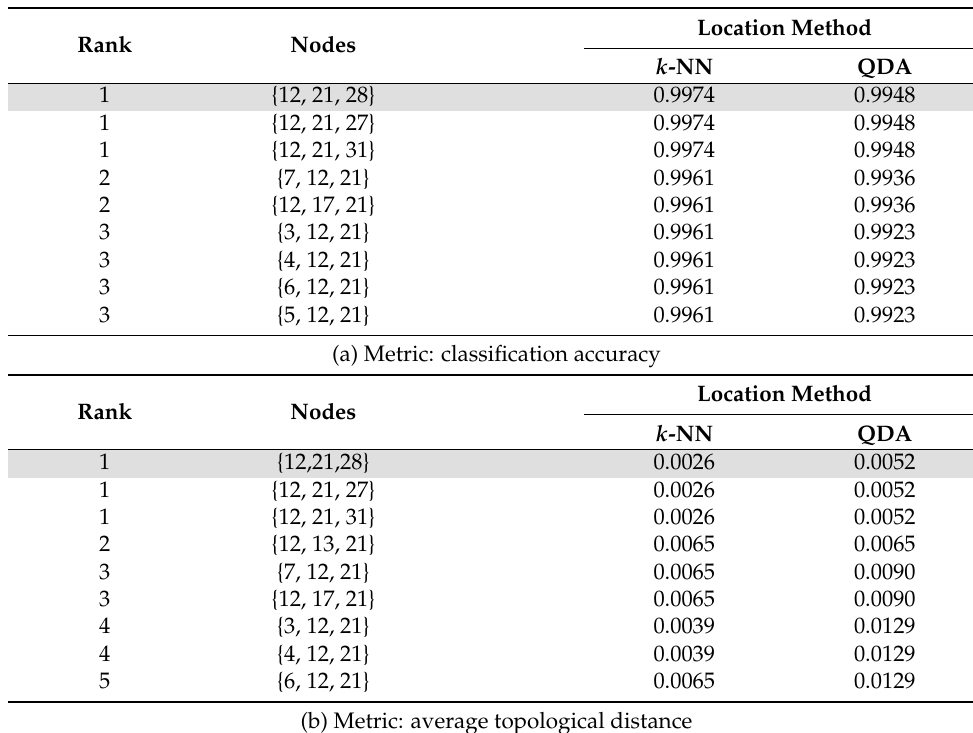
Table 1. Better positions to place three sensors in the Hanoi network, obtained by exhaustive analysis. The shaded selection is the one obtained by Algorithm